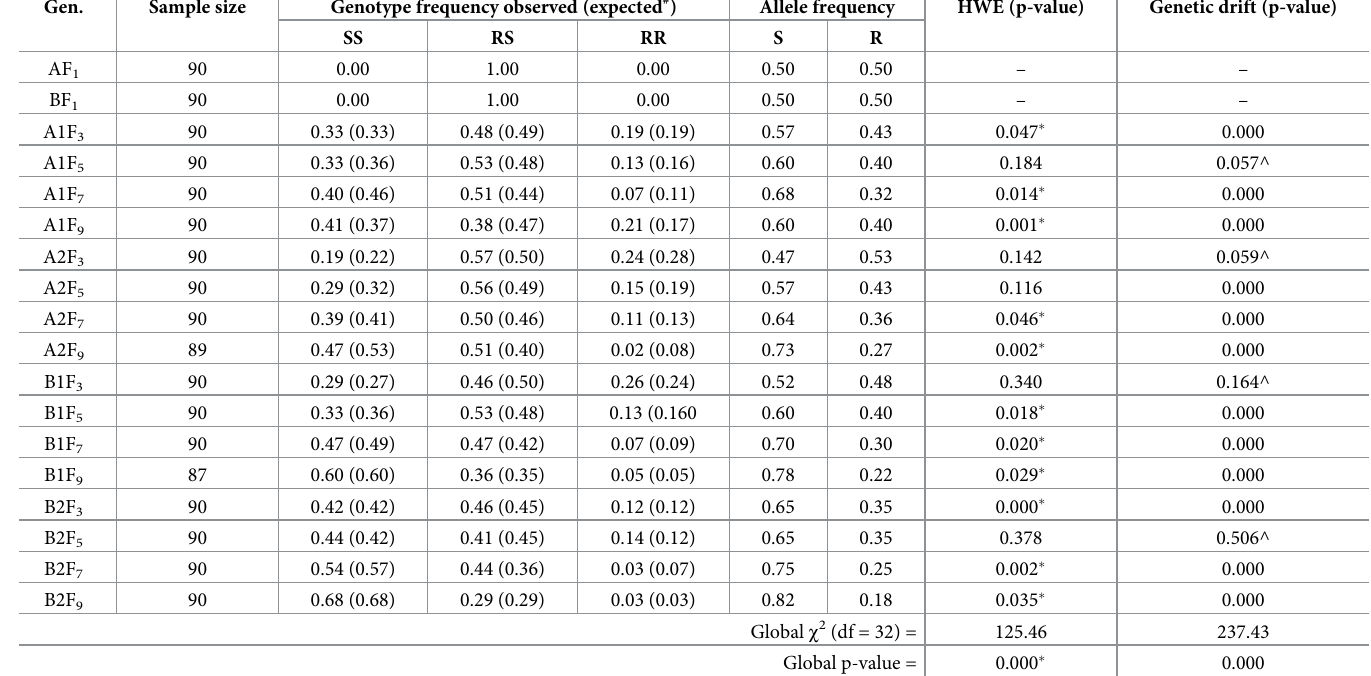
Table 3. Genotype and allele frequencies for each replicate of the CKR x ROCK experiment and their associated Hardy-Weinberg (HWE) and genetic drift p- values. Gen.